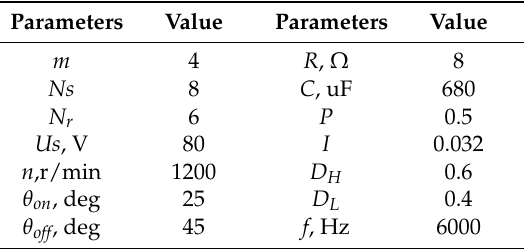
Table 2. Parameters of experiment model.